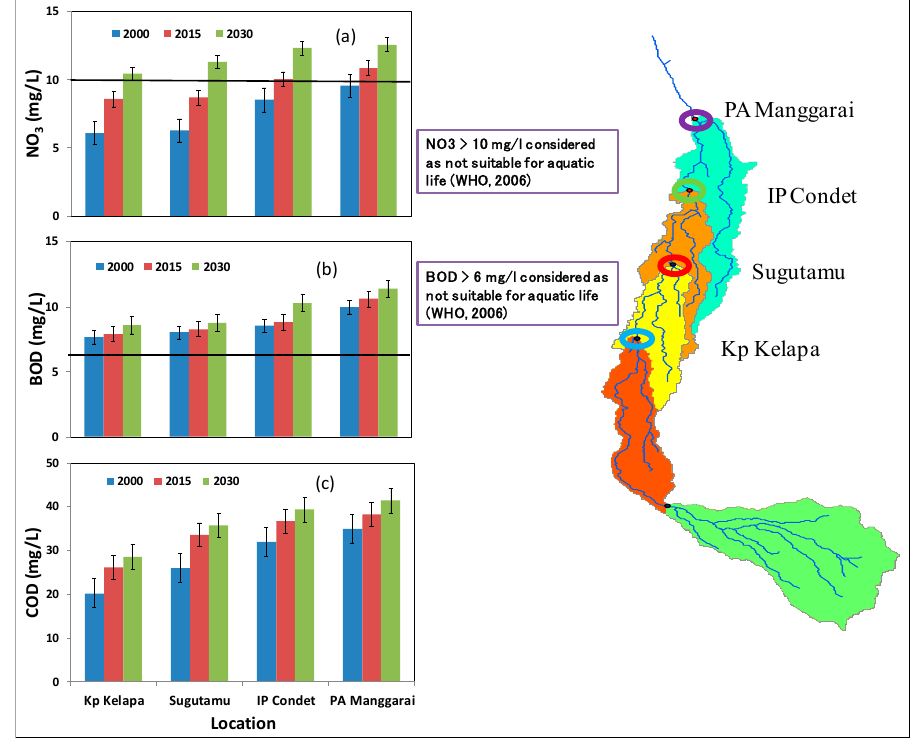
Figure 10. The simulation results of the annual average values of ( a ) NO 3 , ( b ) BOD and ( c ) chemical oxygen demand (COD) for four different locations in 2000, 2015 and 2030 (scenario considering population growth and planned wastewater infrastructure for 2030). (Here, WHO- World Health Organization).